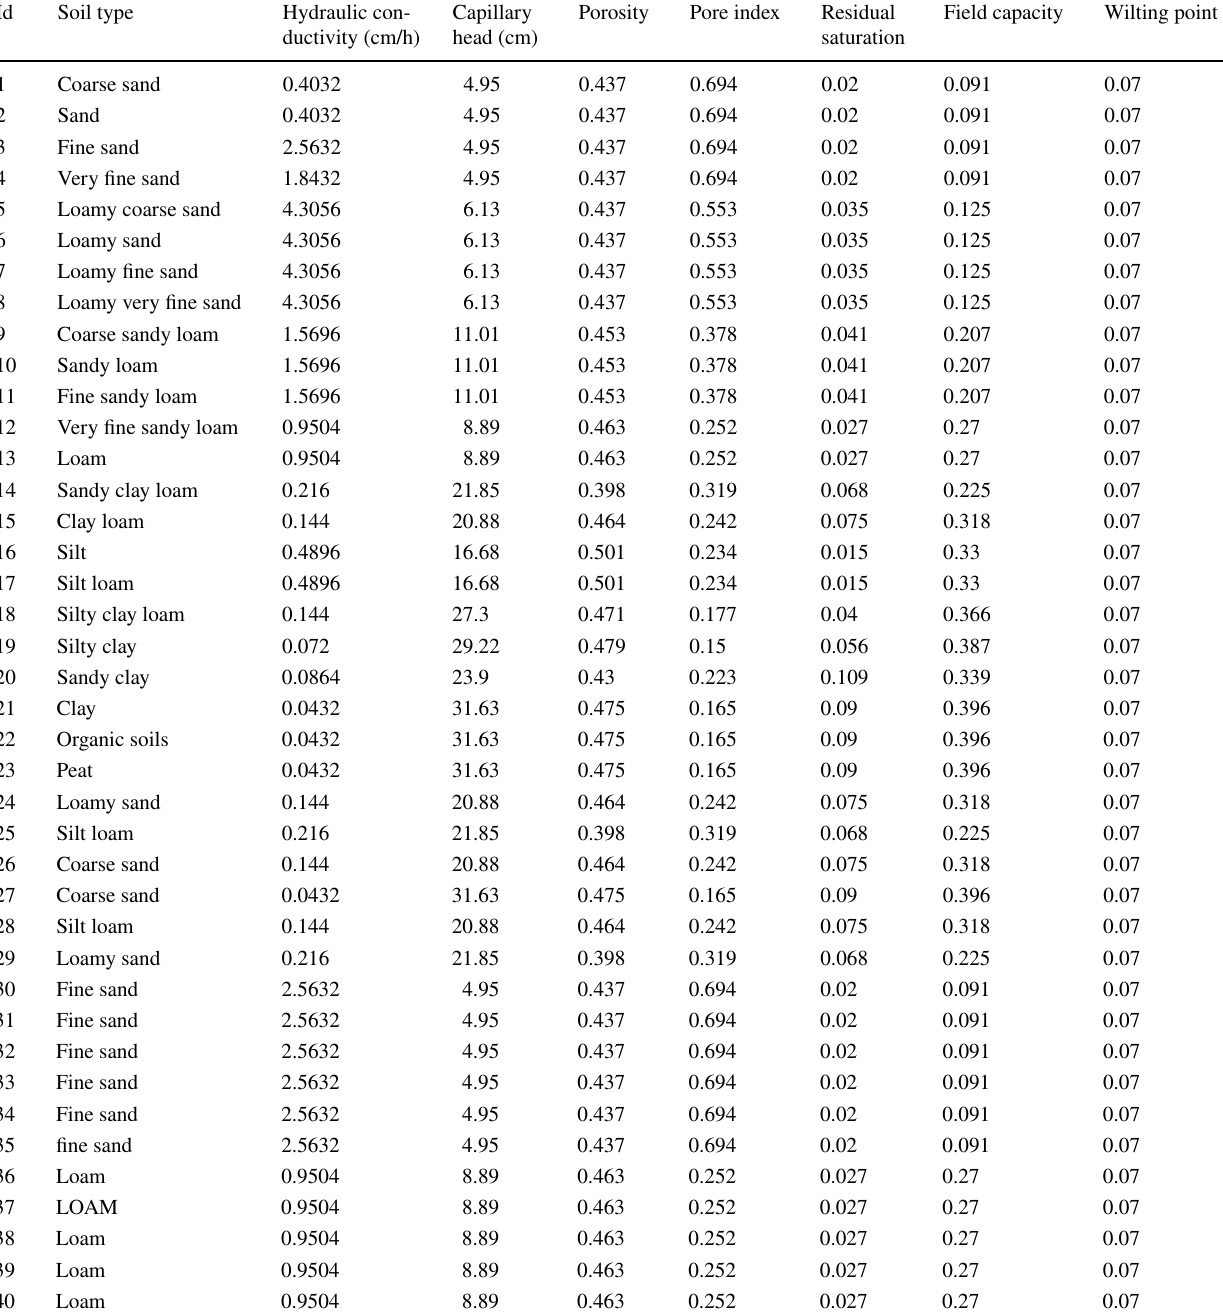
Table 2 Mapping table values in GSSHA model to use in Green-Ampt model based on Fig. 12